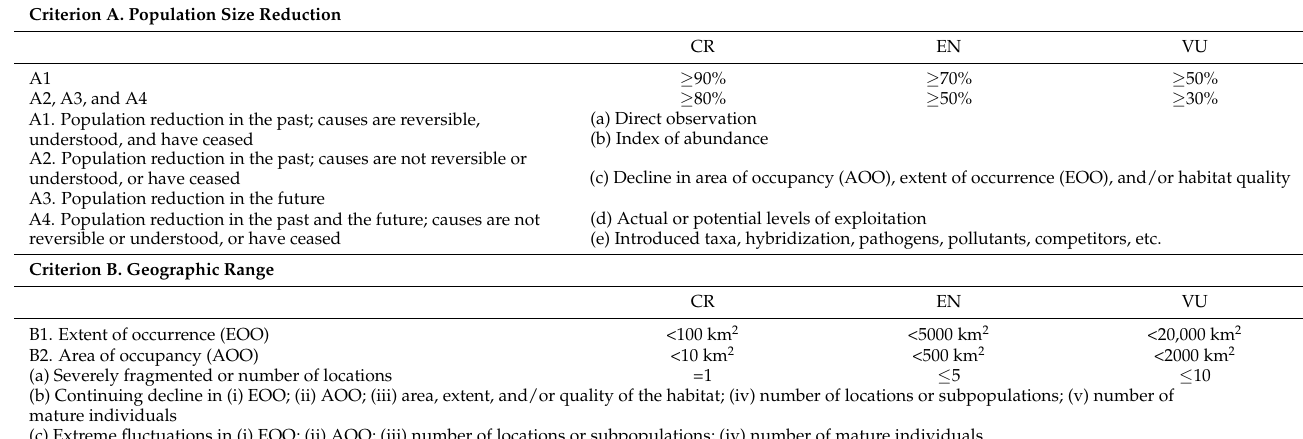
Table 1. Summary of the five criteria (A–E) used to evaluate whether a taxon belongs in an IUCN Red List Threatened Category (i.e., CR, EN, or VU)